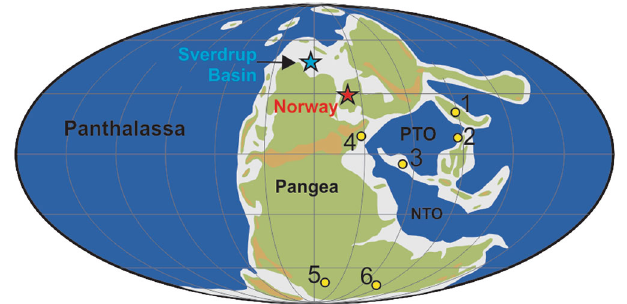
Fig. 1 Late Permian paleogeographic map. Paleogeographic map 97 and locations of studied sections from Norway (red star) and the Sverdrup Basin (blue star). Numbered yellow dots show areas with evidence of continental weathering from (1 – 3) Paleo-Tethys marine deposits 1,14,15 , (4) massive soil erosion at mid-latitudes (Italy) 13 , and (5, 6) high-latitude paleosols (65° − 85°S) 12 . PTO Paleo-Tethys Ocean, NTO Neo- Tethys